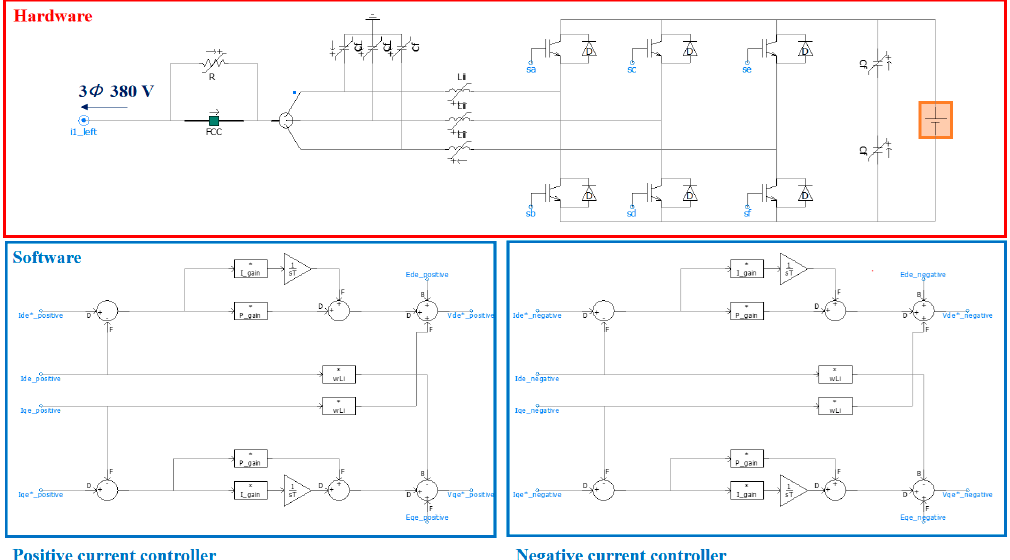
Figure 9. Simulation model of sub-battery energy storage system (sBESS).